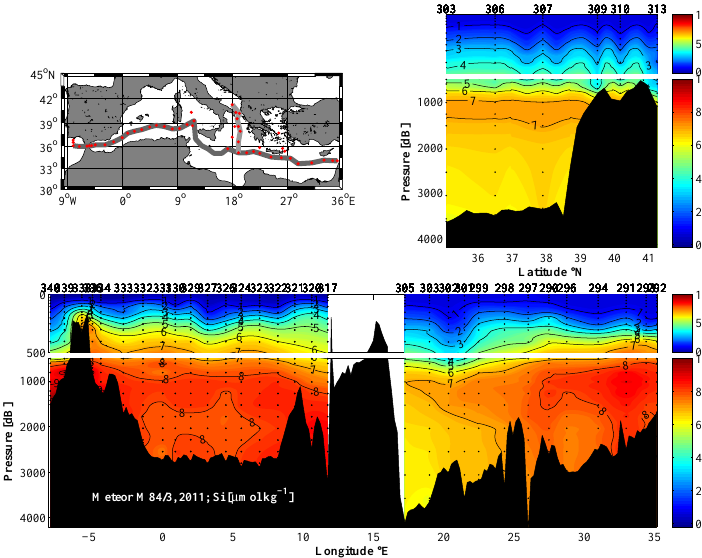
Fig. 9. Similar to Fig. 3, but for